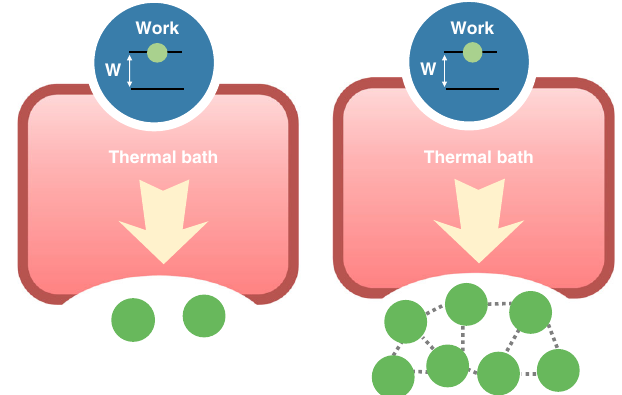
Fig. 1 Correlations as a resource. In the single-shot regime, the creation of N correlated copies of a given state has a smaller work cost than creating N independent copies. In the asymptotic limit, this energetic cost per copy converges to the standard non-equilibrium free energy